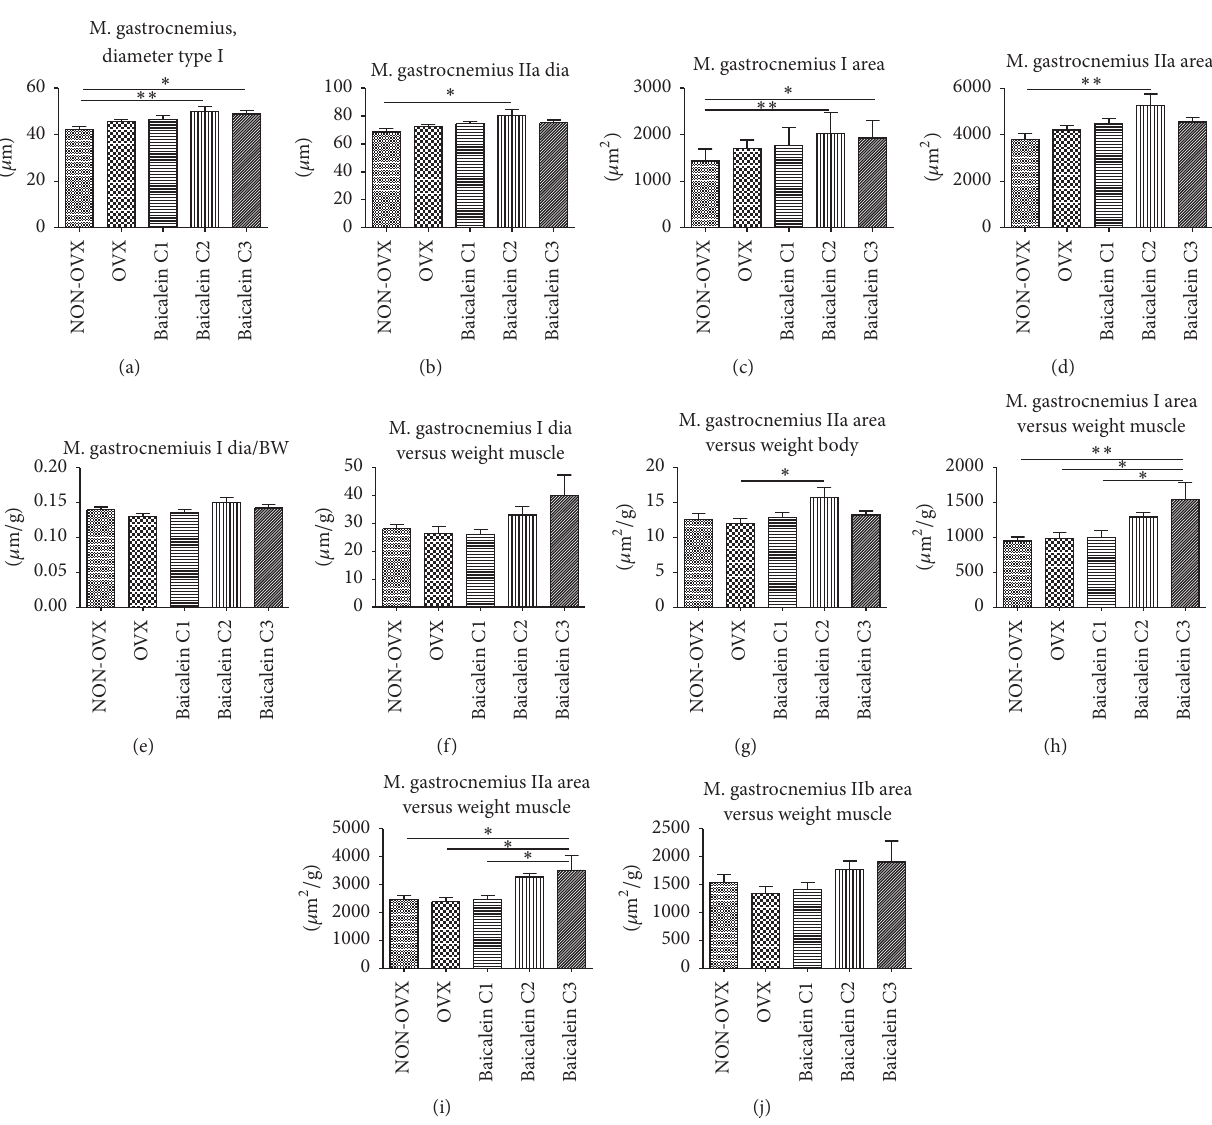
Figure 5: Diameter and area of M. gastrocnemius fibre types I and IIa and their relation to muscle and body weights. The diameter of single type I fibres was significantly greater in the baicalein C2 and baicalein C3 groups compared with the NON-OVX group ((a), 𝑛 = 47 ). Type IIa fibres showed a greater diameter in the baicalein C2 group compared with the NON-OVX group ((b), 𝑛 = 47 ). The area of type I muscle fibres was significantly greater in the baicalein C2 group and the baicalein C3 group versus the NON-OVX group ((c), 𝑛 = 47 ), whereas the area of type IIa muscle fibres was significantly greater in the baicalein C2 group versus the NON-OVX group ((d), 𝑛 = 47 ). No significant differences were noted in the fibre to body weight ratio in type I fibres of M. gastrocnemius ((e), 𝑛 = 47 ). No significant differences in type I fibre diameter in relation to muscle weight could be detected ((f), 𝑛 = 46 ). The only significant difference regarding the area to body weight ratio was between the baicalein C2 group and the OVX group, where the former had the greater area to body weight ratio ((g), 𝑛 = 47 ). Baicalein C3-treated rats had a significantly higher muscle fibre area to muscle weight than the NON-OVX, OVX, and baicalein C1-treated rats ((h), 𝑛 = 46 ). For type IIa fibres, significant differences in area to single muscle weight index were noted between the NON-OVX group and baicalein C3 group and between OVX group and the baicalein C3 group as in baicalein C1 group and baicalein C3 group ((i), 𝑛 = 46 ). For type IIb fibres, no differences in area to single muscle weight index were recorded ((j), 𝑛 = 46 ). ∗ 𝑝 < 0.05 and ∗∗ 𝑝 < 0.01 indicate significant